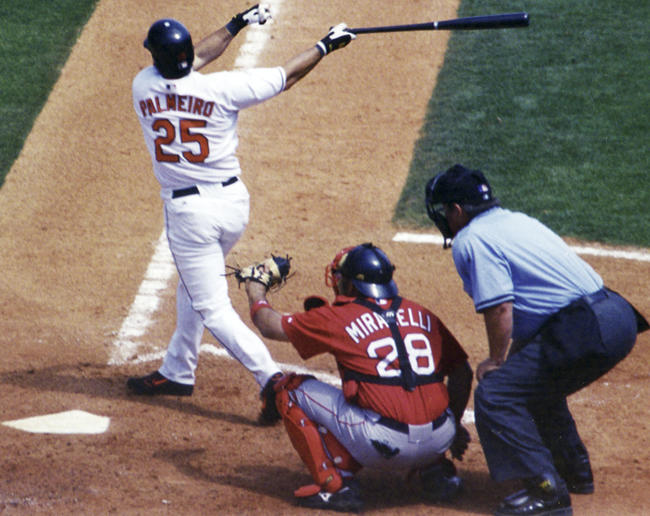
Pfizer Hired 39-Year-Old Baseball Player Rafael Palmeiro as a Spokesman for Viagra